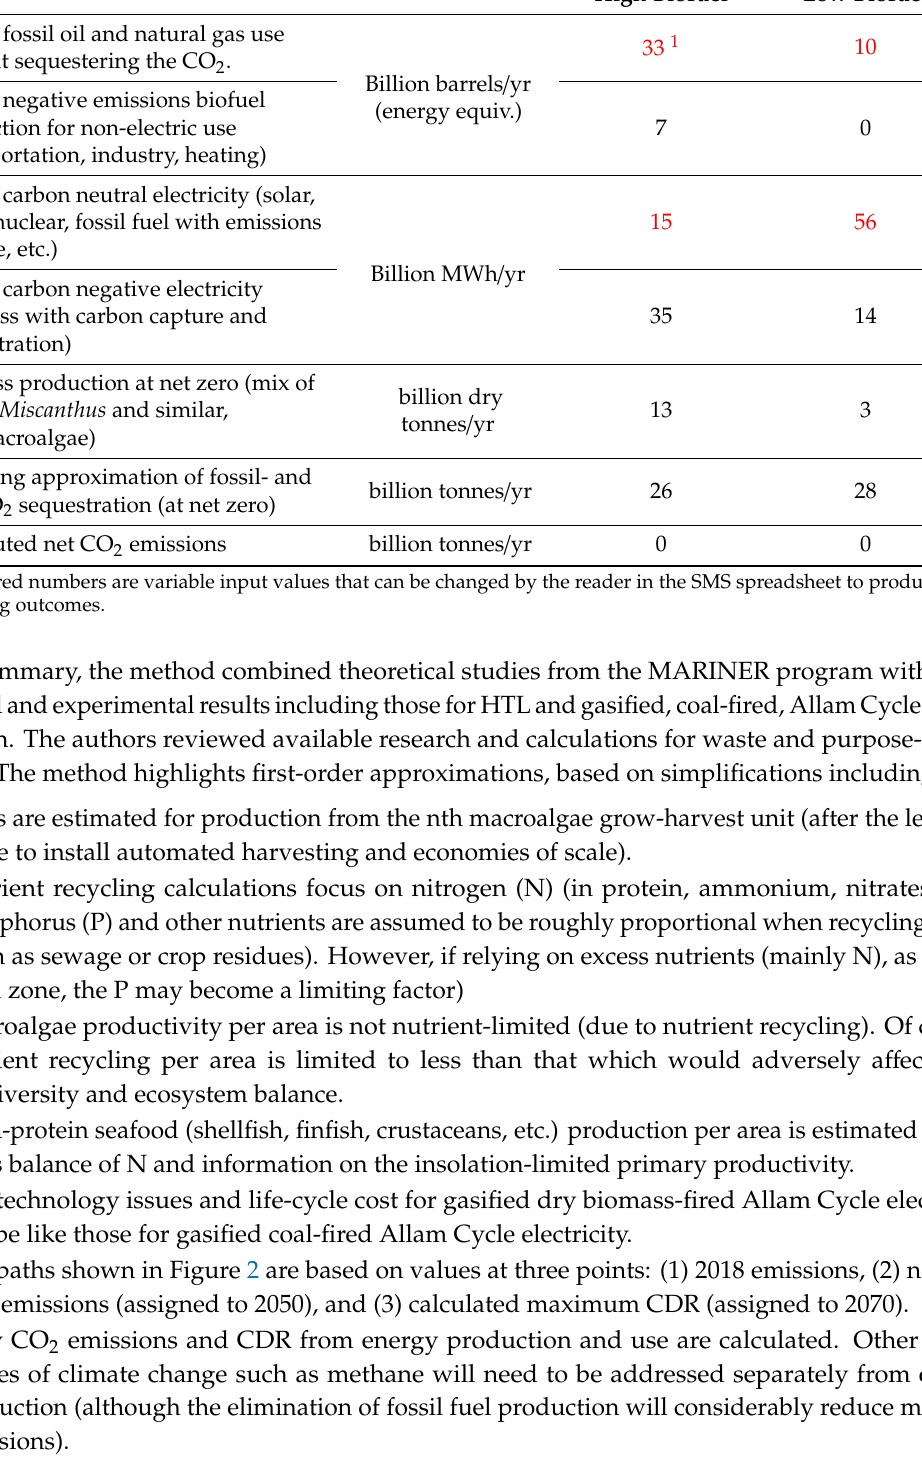
P electric : High P fuel : Low Bio-Electricity, Bio-Electricity, Low Biofuel High Biofuel 33 1 10 Billion barrels / yr (energy equiv.)